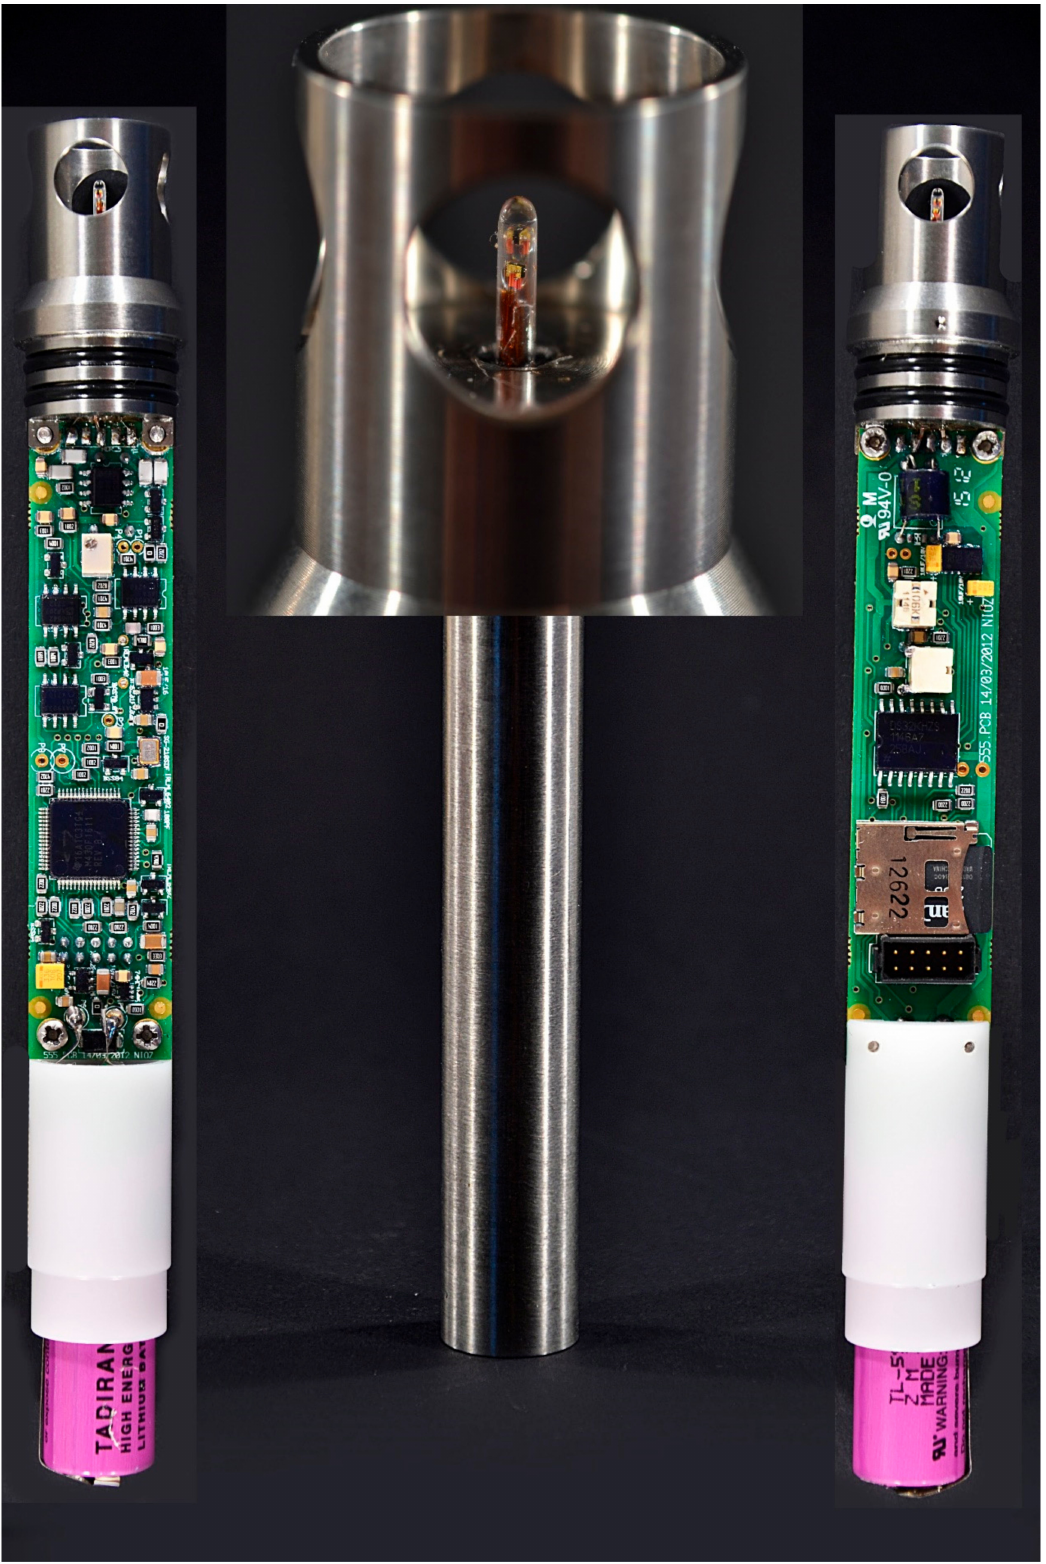
Figure 1. Image of NIOZ4 with micro SD-card and two induction-spools ( left ), titanium housing, sensor-tip magnification ( middle ), and main electronics ( right ). The overall length is 0.18 m and its diameter is 0.023 m and its weight is 0.23